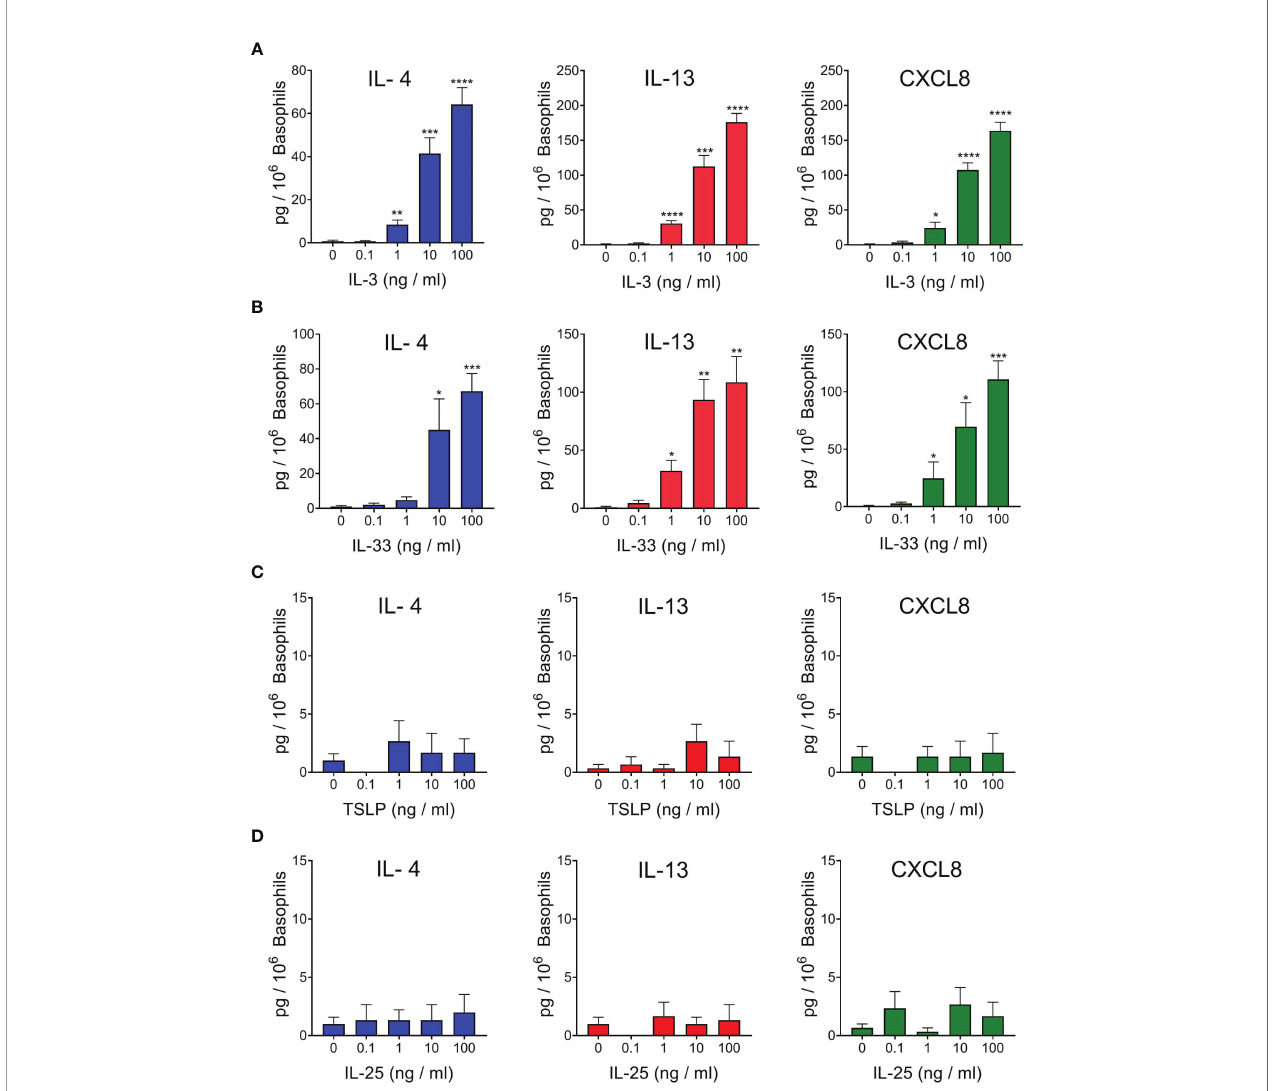
FIGURE 1 | Effects of increasing concentrations of rhIL-3 (A) , rhIL-33 (B) , rhTSLP (C) , and rhIL-25 (D) on IL-4, IL-13, and CXCL8 release from different preparations of human basophils (n=5). Basophils were incubated (18 hours at 37°C) with the indicated concentrations of cytokines. At the end of incubations, cell-free supernatants were collected and analyzed for IL-4, IL-13, and CXCL8 protein by ELISA. * p < 0.05; ** p < 0.01; *** p < 0.001; **** p <